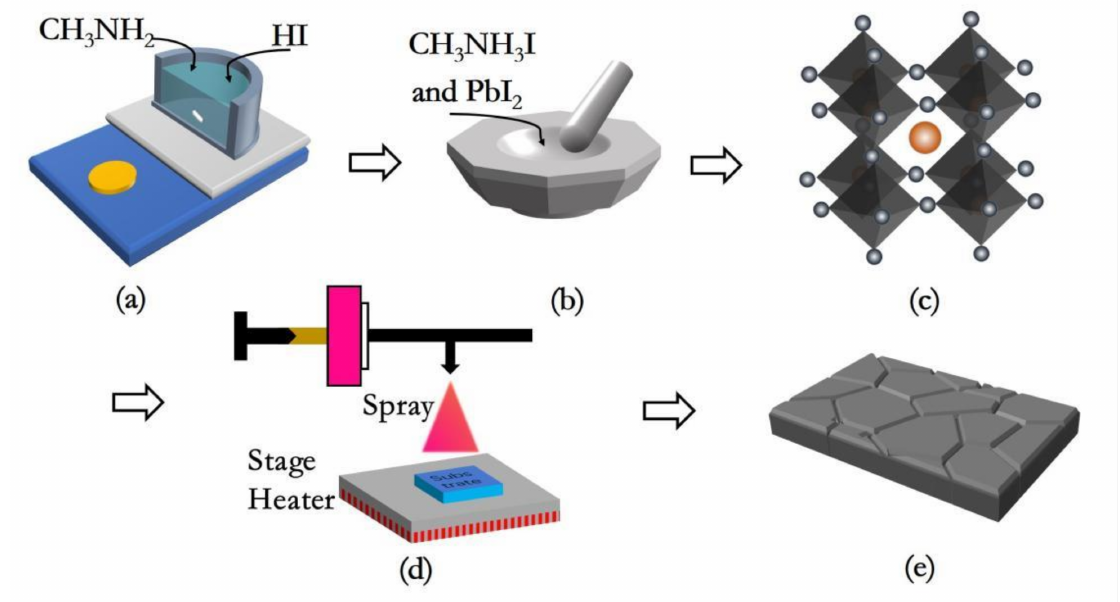
Figure 2. ( a ) Ice bath method; ( b ) grinding; ( c ) the structure of MAPbI 3 powder; ( d ) aerosol deposition method; and ( e ) the polycrystalline layer structure of MAPbI 3 thin film. The different relative humidity (RH) environments were obtained by saturated salt solutions of LiCl, MgCl 2 , Mg (NO 3 ) 2 , NaCl, KCl, and KNO 3 in closed containers. The environments above these solutions can provided RH levels of 11, 33, 54, 75, 85, and 94%, respectively. The impedance of the sensor was measured by an impedance analyzer (Hioki 3532-50 LCR). The experimental setup was illustrated in Figure 3. The influence of illumination on the MAPbI 3 -based sensor was reflected by impedance variation with and without light provided by 10 small red LED